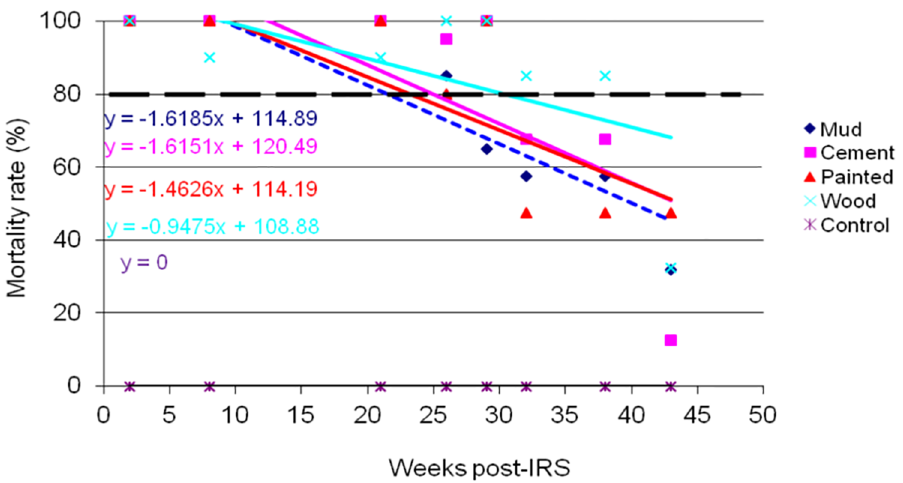
Fig 2. Cone wall bioassay response of susceptible strain An . gambiae s . s to p-methyl 300 CS sprayed in different wall surfacesin Bukindo village, Ukerewedistrict. The dashedline representsthe WHO threshold of 80%